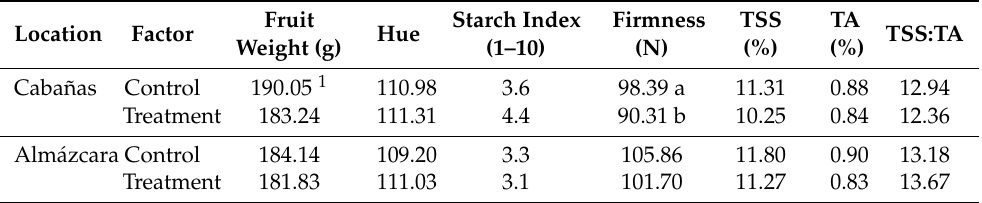
Table 4. Effect of pruning on instrumental quality attributes of apple cv. ‘Reinette du Canada’ at harvest.